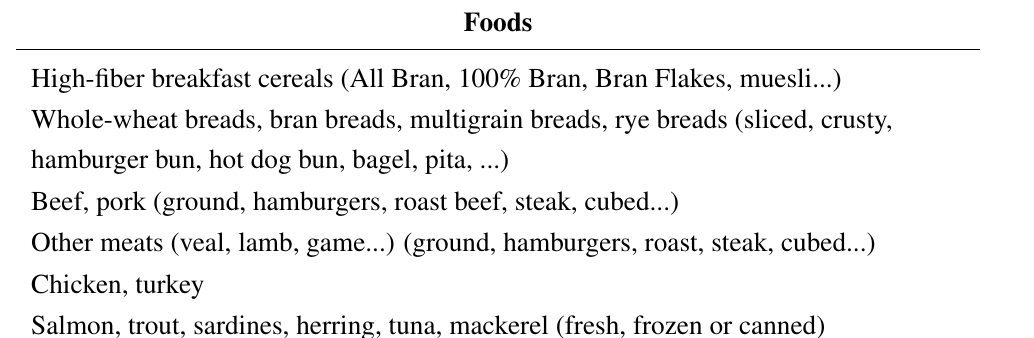
Table A2. Short Diet Questionnaire food and beverage list. Foods